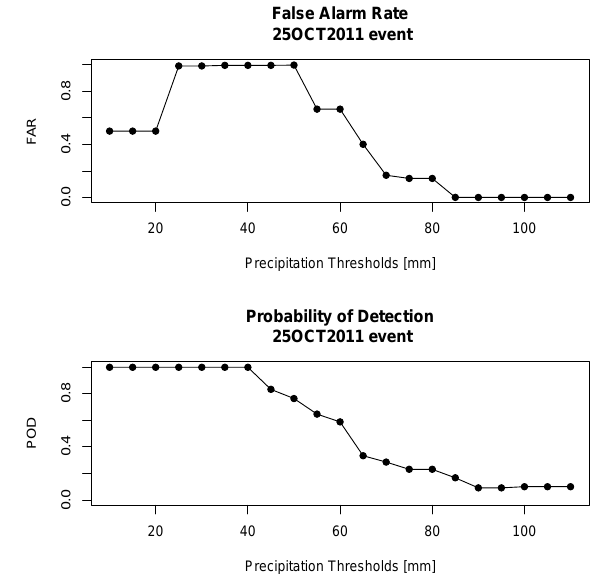
Figure 5. Study case 25OCT2011: false alarm rate (top) and prob- ability of detection (bottom) skills obtained when validating the ac- cumulated 24h rainfall predicted by the WRF model with the rain- fall data observed at the rain-gauge locations displayed in Fig.